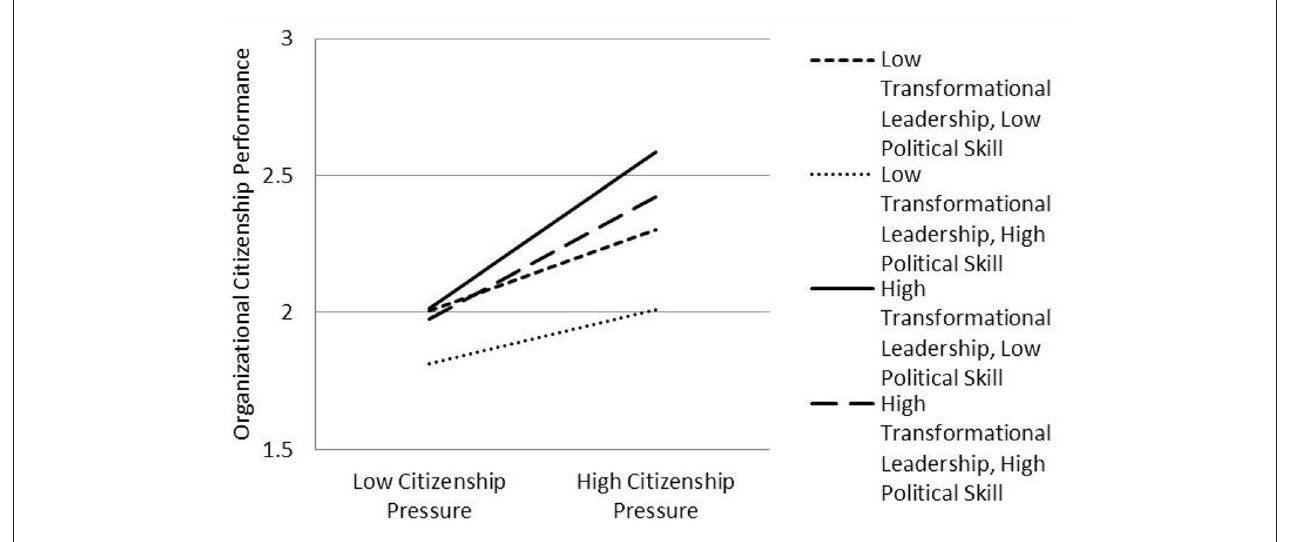
FIGURE 3 | The moderating role of political